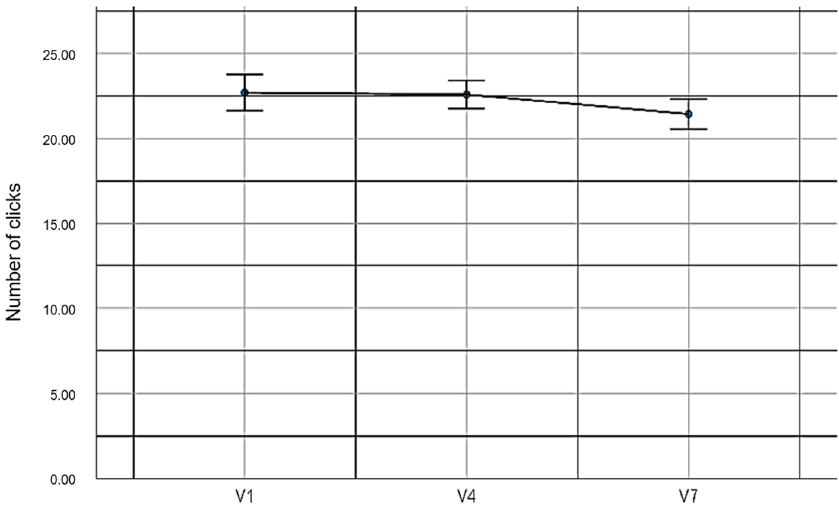
Figure 8. Number of clicks made in the pairing cards experiment.